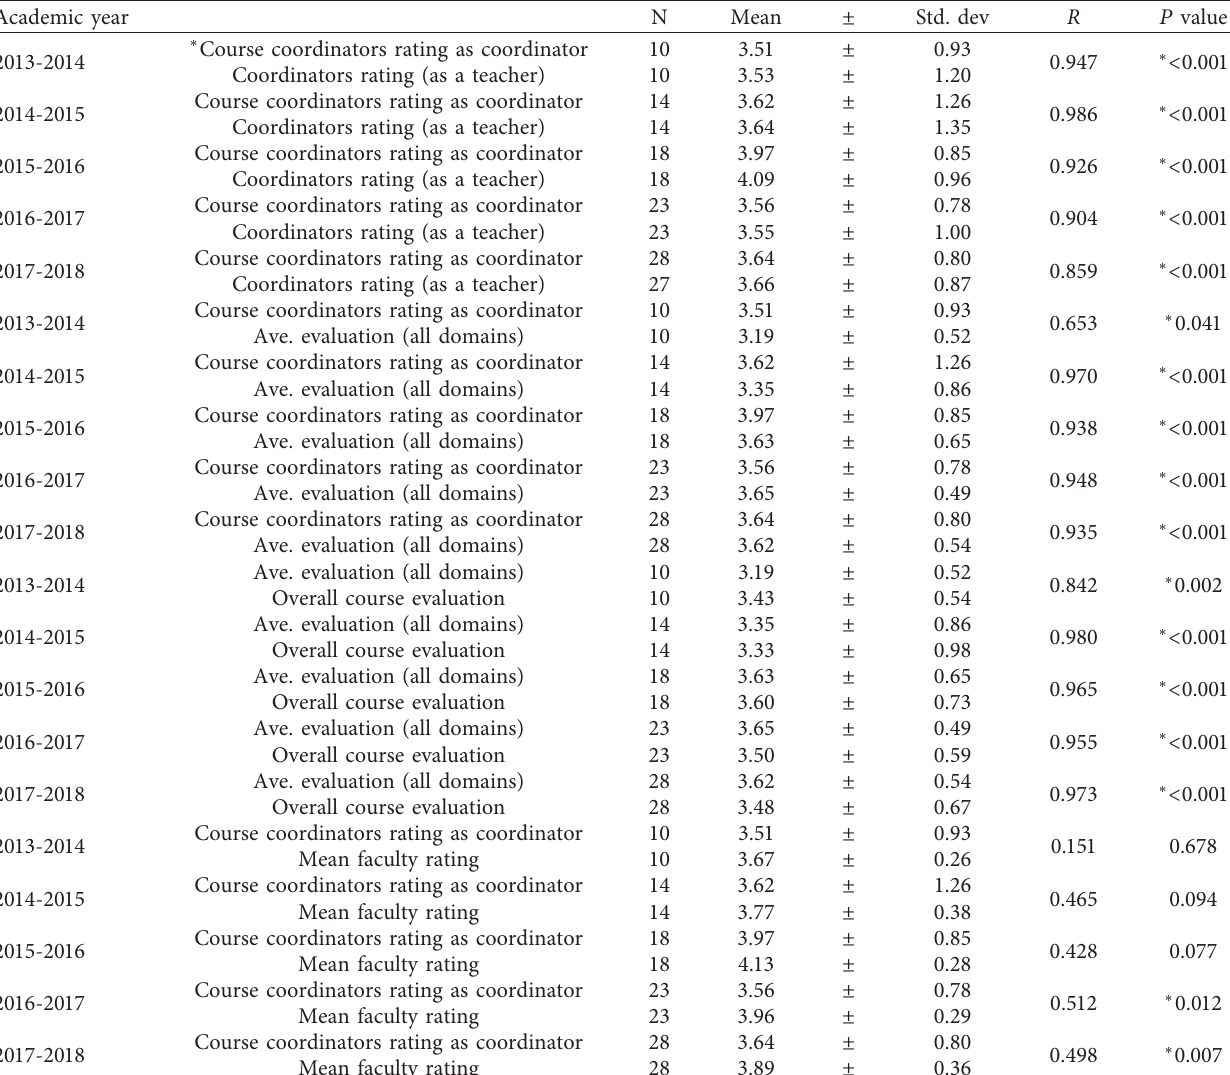
Table 5: Difference and association trend as per academic year.